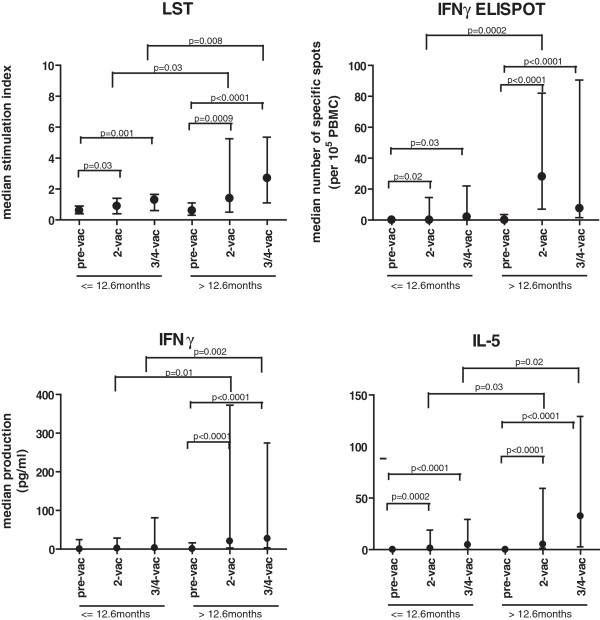
The group of relatively longer living patients displays a stronger HPV16-specific immune response upon vaccination. The patients are grouped according to the median survival time (12.6 months) of the whole group. The strength (median + interquartile range) of the indicated immune response to all 6 pools of HPV16 E6 and E7 peptides for the group of patients with survival time equal or less than 12.6 months versus that of the group of patients with a survival time beyond 12.6 months measured before vaccination (pre-vac), after 2 vaccinations (2-vac) and after the 3rd or 4th vaccination (3/4-vac) is given. Only when the strength of the immune response was significantly different, this is indicated by the p-value.